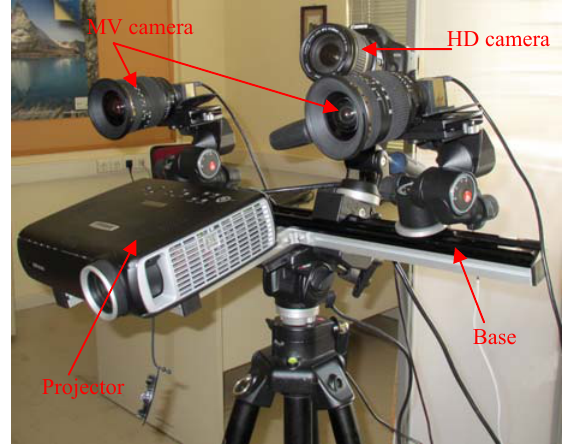
Fig. 2. The SL2 model of XYZRGB structured light scanner